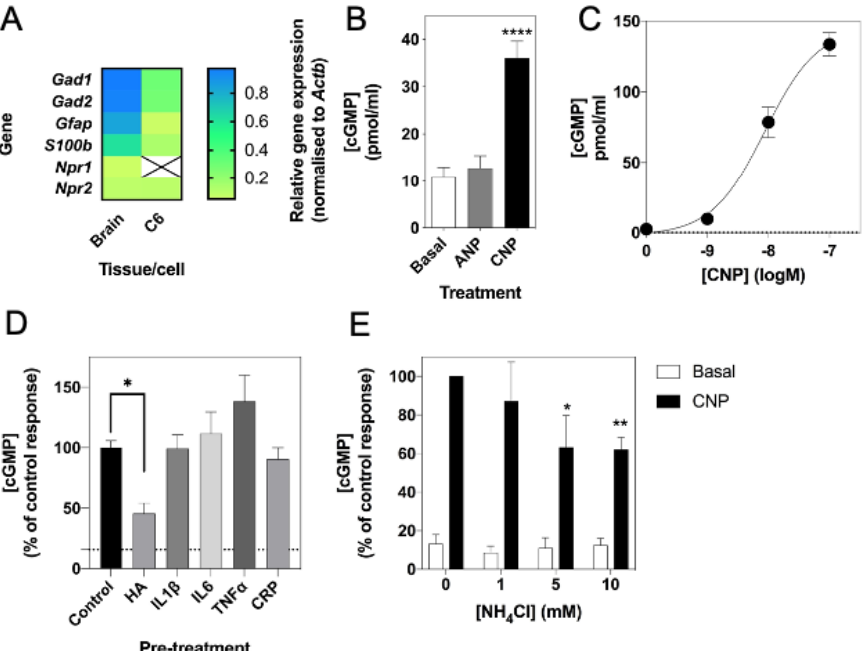
Figure 1. Molecular and pharmacological characterization of natriuretic peptide system in rat C6 glioma cells. ( A ) Multiplex RT-qPCR was performed on RNA extracted from rat brain tissue or C6 cells. The data shown are mean relative gene expression, normalized to Actb , of 3 to 6 individual RNA extractions. ( B ) Total cGMP accumulation in C6 cells treated with 0 or 100 nM